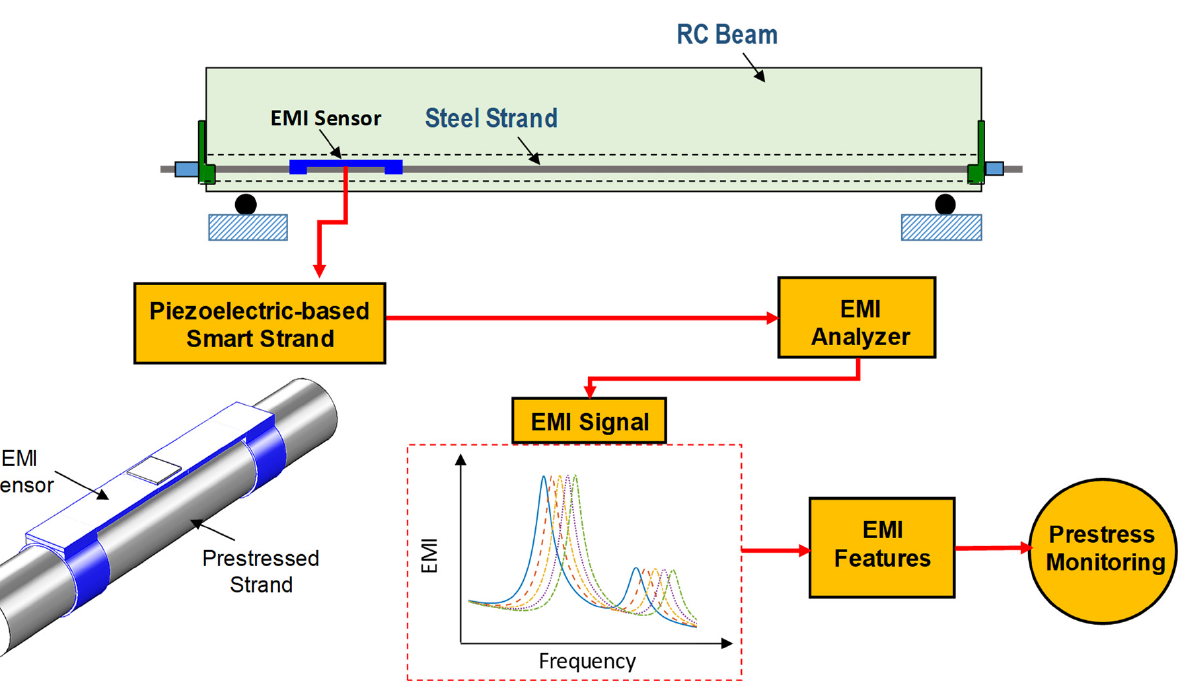
Figure 1. Framework for PS force monitoring using the concept of piezoelectric-based smart strand.